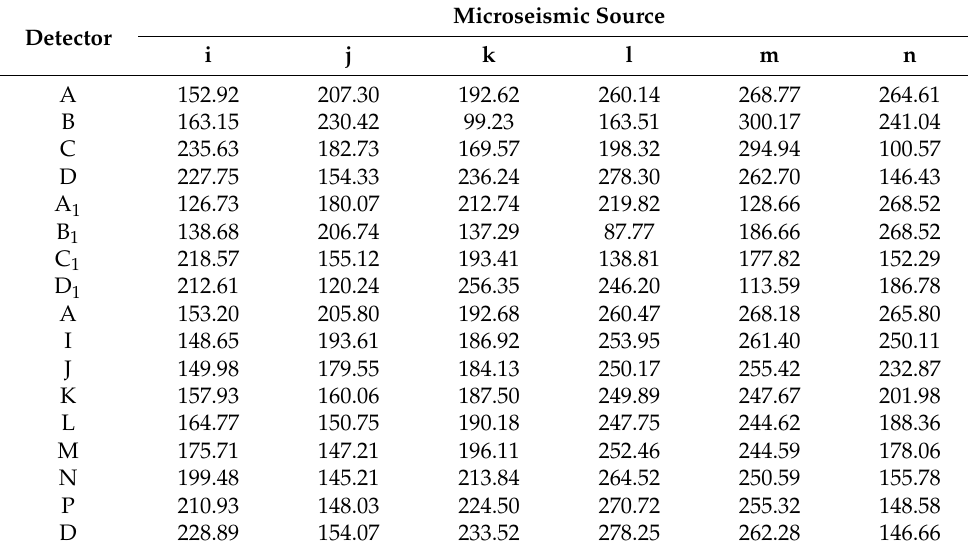
Table 4. Arrival time of each detector (ms).